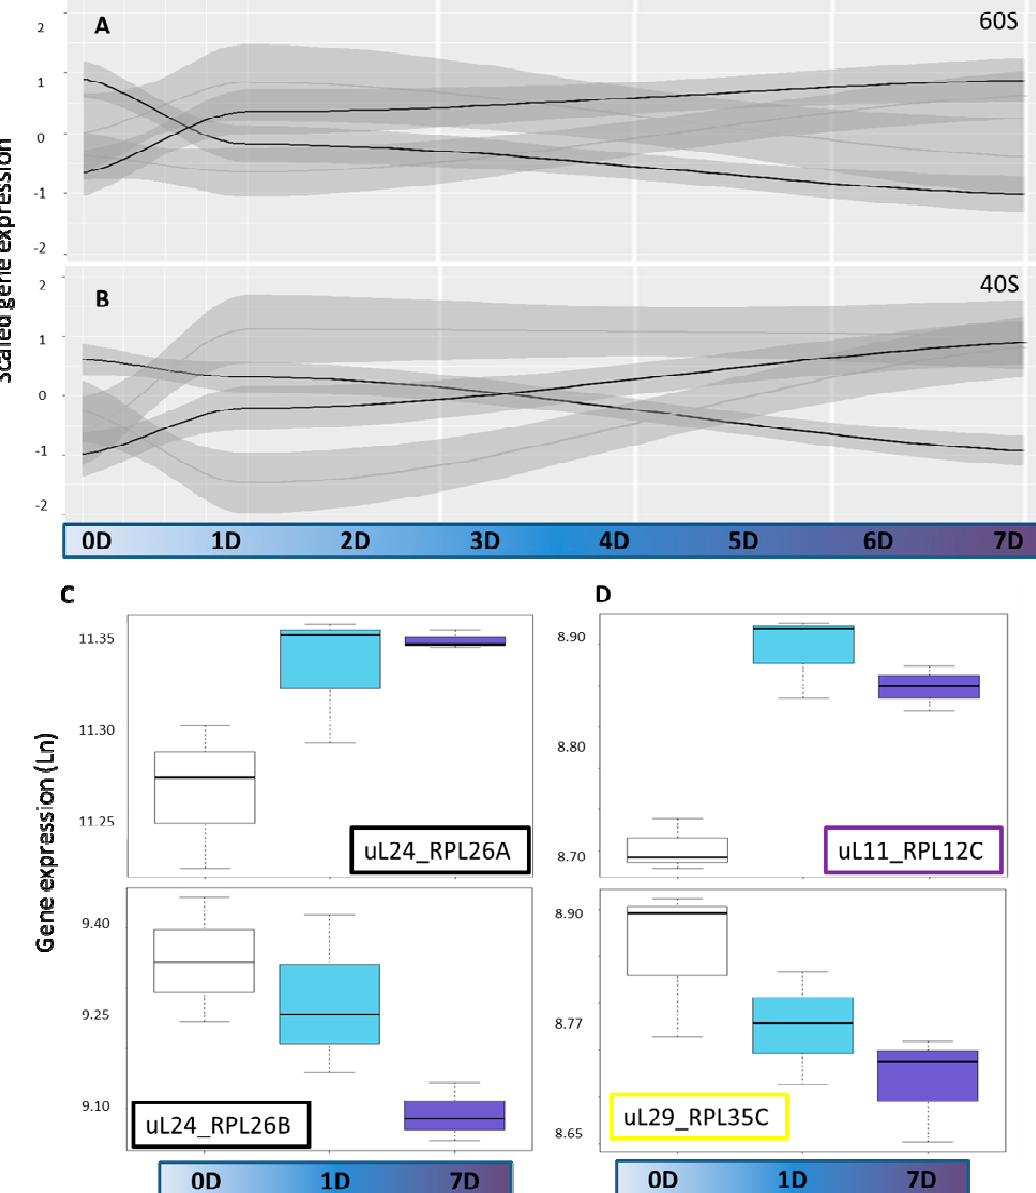
Figure 2. Changes of gene expression of cytosolic structural ribosome proteins in roots of Arabidopsis thaliana acclimating to suboptimal temperature. Arabidopsis wild type Col-0 plants grew at 20 °C to vegetative developmental stage 1.10 [55]. The transcriptome of whole root systems was profiled prior to a 10 °C cold shift (0D) and at 1 or 7 days after (1D or 7D) the shift. Replicates n = three independent biological replicates at each time point. Probe hybridization intensities are natural logarithm-transformed, quantile-normalized, and statistically tested applying a generalized linear model with details reported in the methods section using R functions compiled in the GitHub repository RandoDiStats (https://github.com/MSeidelFed/RandodiStats, accessed on 30 April 2021). Scaled differential intensities cluster into four expression trends (K-means clustering) and identify response groups of cytosolic RP genes (Table S2C). Cluster means, indicated by solid grays and standard error intervals, light gray underlay, reveal four expression trends in ( A ) 60S LSU and ( B ) 40S SSU. ( C ) Example of inversely regulated paralog transcripts from the RPL26 (uL24) ribosomal protein family. ( D ) Examples of up and downregulated transcripts of the uL11 and uL29 ribosomal protein families respectively. The remaining paralogs within these two exemplary families did not show significant changes in their abundances and thus are not shown in the figure. Note that ( C , D ) represent non-scaled natural logarithm-transformed probe hybridization values. Colored boxes of ribosomal protein names indicate the temperature dependent type of upregulation or downregulation in paralog expression patterns (see Figure